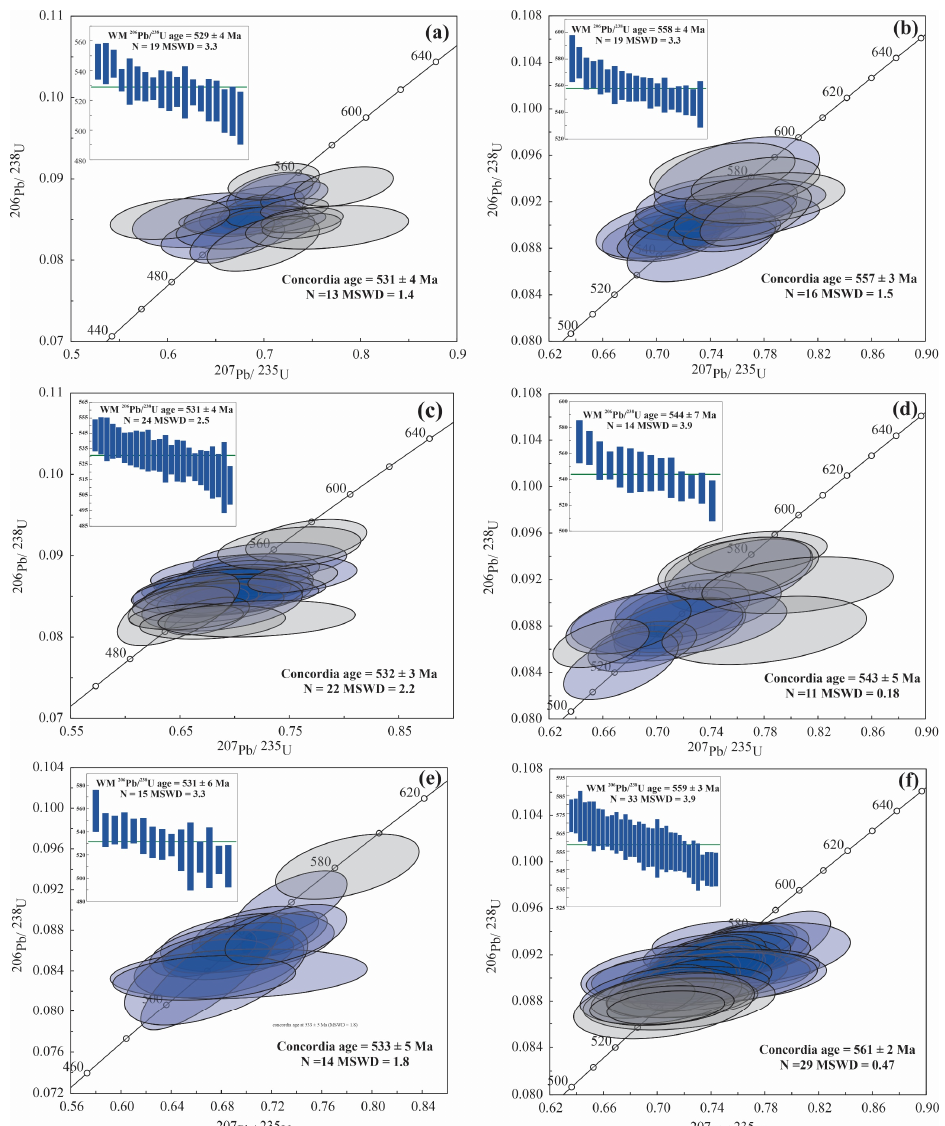
Figure 9. ( a – f ): U-Pb geochronological data of zircons analysed from gabbros presented in Wetherill diagrams: ( a ) NB8, ( b ) NB15, ( c ) NB17, ( d ) NB20, ( e ) NB36, and ( f ) NB44. Blue circles represent concordia population and grey circles represent discordant spots. Inset shows weighted mean 206 Pb/ 238 U ages.